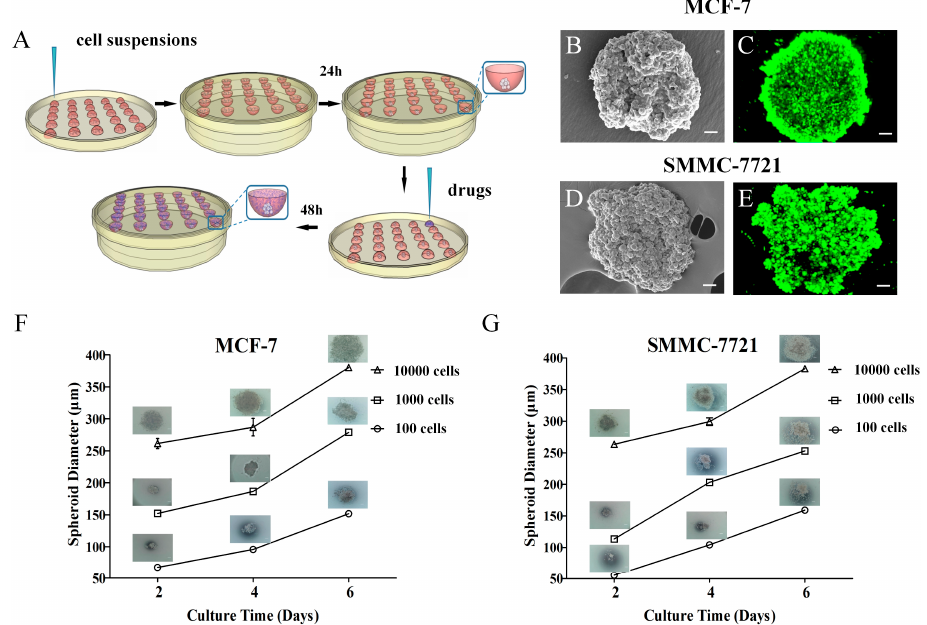
Figure 1. Formation and characterization of 3D tumor spheroids. ( A ) Schematic representation of 3D tumor spheroid formation using a hanging drop method; ( B ) SEM images of MCF-7 spheroids after culture for 2 days and ( C ) live/dead stained fluorescence images of MCF-7 spheroids after culture for 2 days and ( D , E ) SMMC-7721 spheroids over 4 days cultures, respectively. Cell growth curves of ( F ) MCF-7 and ( G ) SMMC-7721 cell spheroids with different cell density. Error bars, s.d. ( n = 3). Scale bars, 20 μ m.